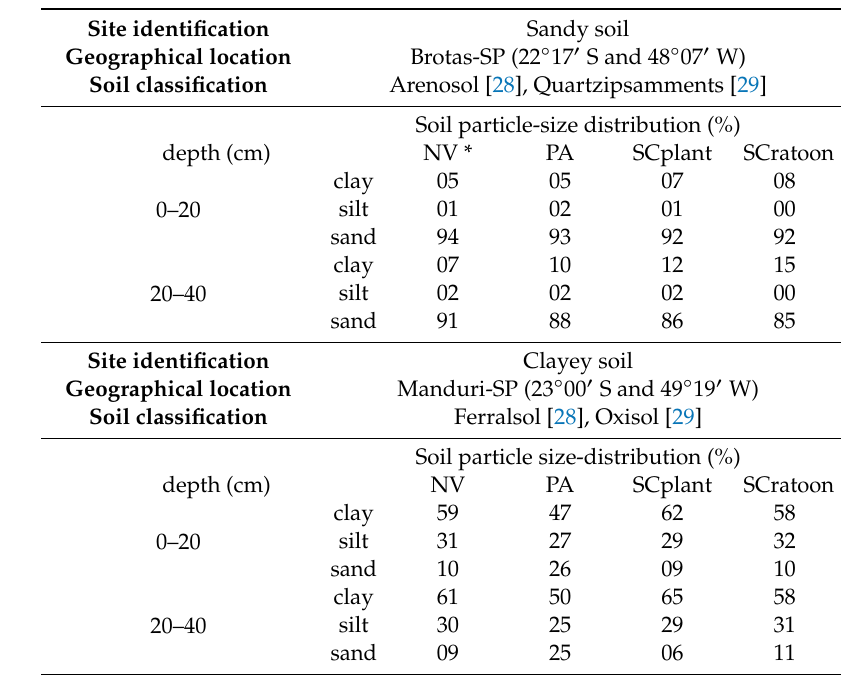
Table 1. Location and soil particle-size distribution at the Sandy and Clayey soil in the State of S ã o Paulo,